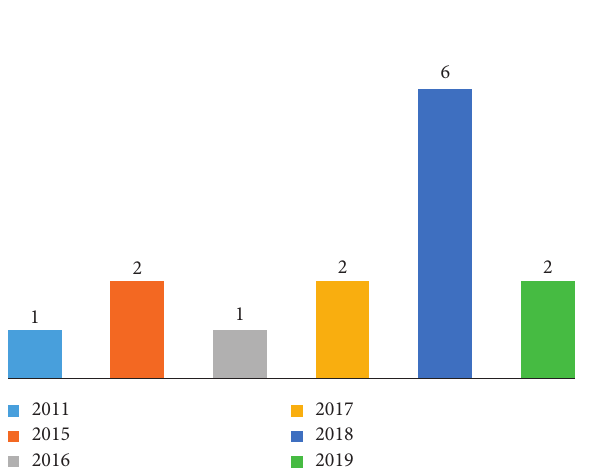
Figure 5: Trends in